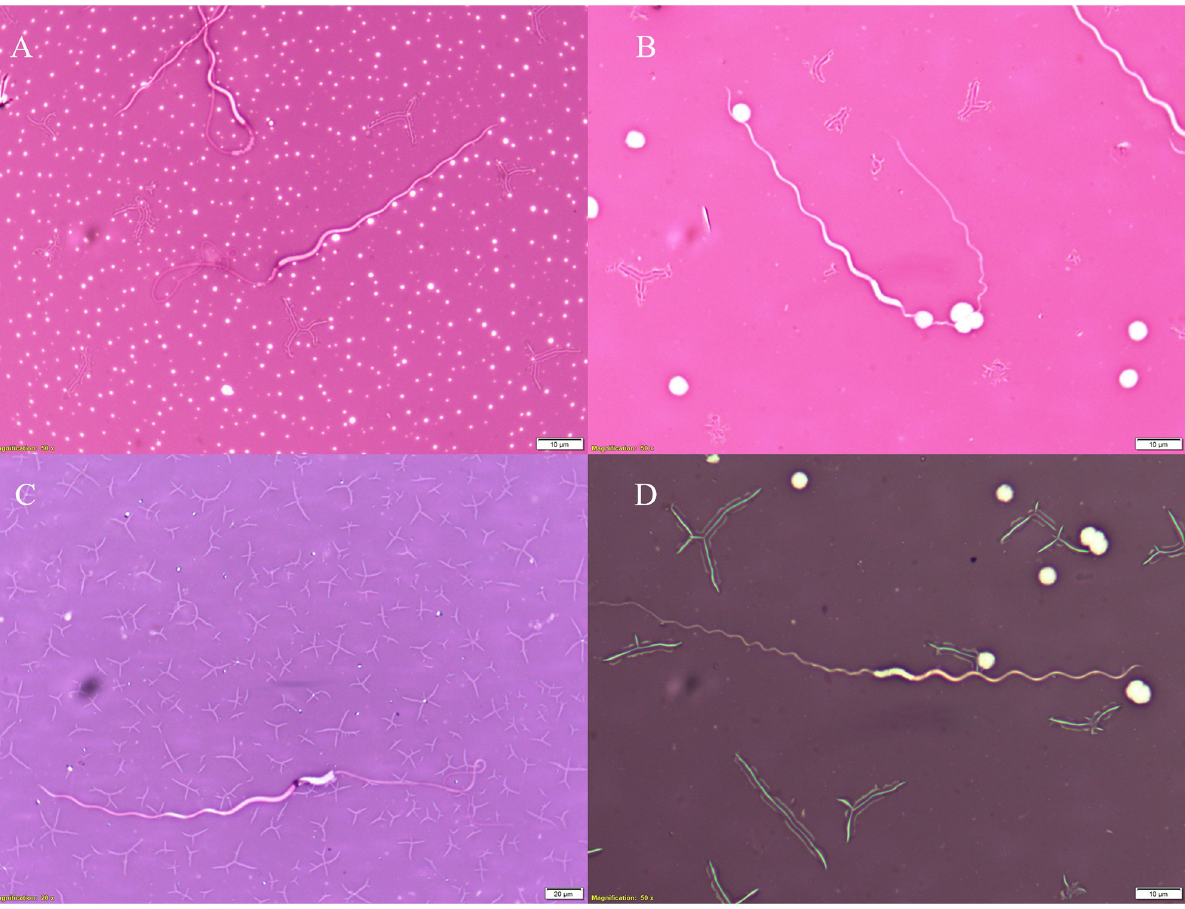
Fig 4. Tuatara ( Sphenodon punctatus) sperm viability images. (A + C) Sphenodon punctatus sperm stained with Eosin Nigrosin to assess viability (membrane integrity). Sperm whose heads are penetrated with stain are non-viable (A + C), while sperm heads that reject stain, and thus appear white, are considered viable (B + D). Various artefacts from the cloaca, in addition to crystals formed by the stain cracking as it dried, are also visible.